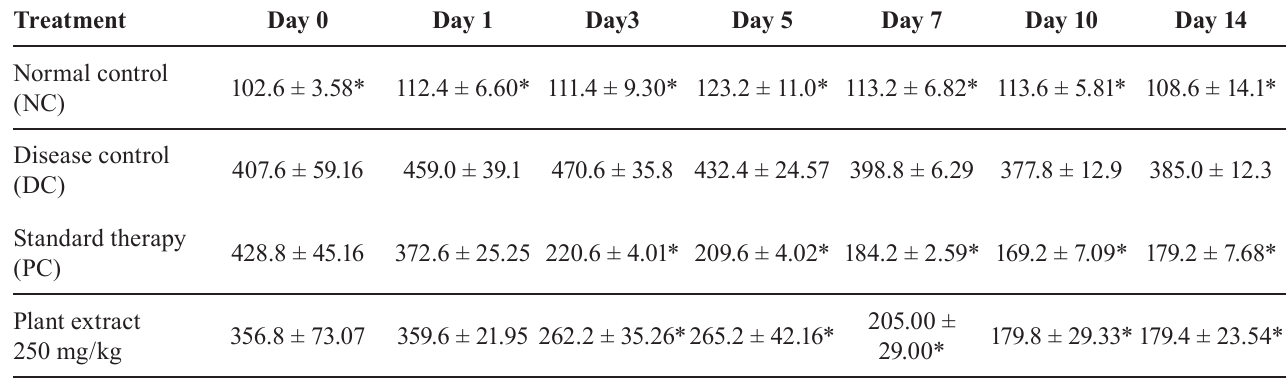
TABLE II – Fasting blood glucose level (mg/dL) in diabetic rats exposed to M. neglecta extracts